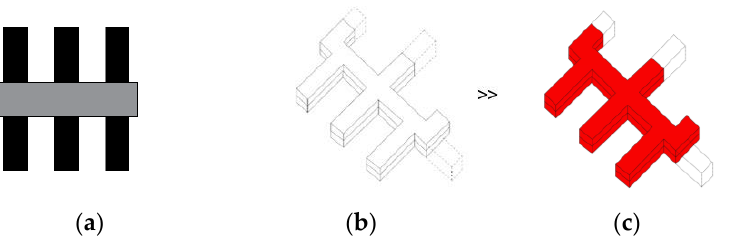
Figure 4. Comb layout (finger-plan). ( a ) Planimetric scheme; ( b ) Axonometric scheme; ( c ) Axono- metric scheme with the minimum area that must be dedicated to the infectious disease section indicated red.